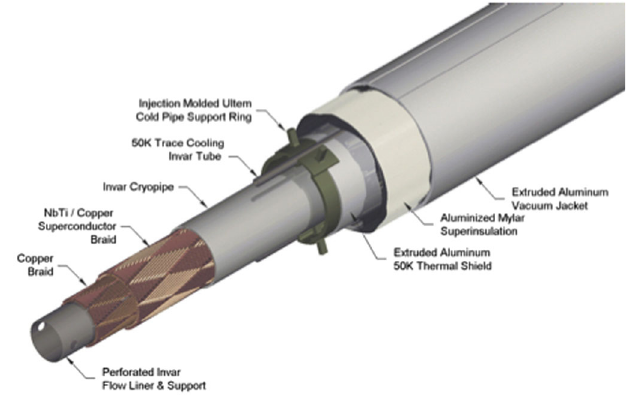
FIG. 2. The superconducting transmission line, proposed as a current source